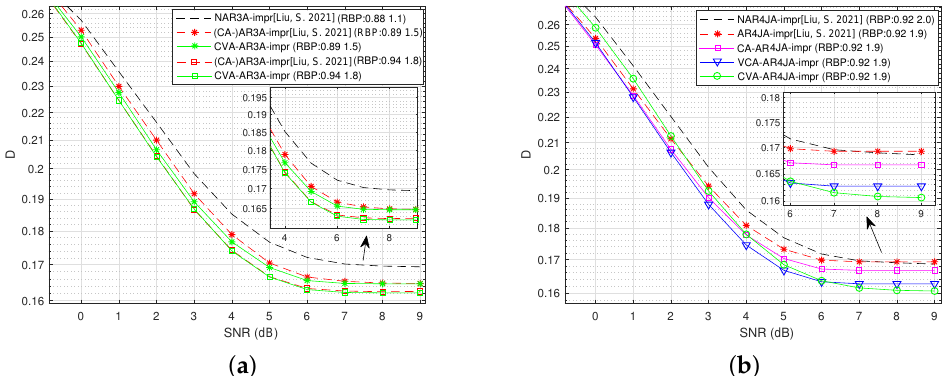
Figure 6. The performance of the optimized codes for lossy compression over AWGN channels (code rate: 0.4). ( a ) Based on AR3A codes [11] ( b ) Based on AR4JA codes [11].